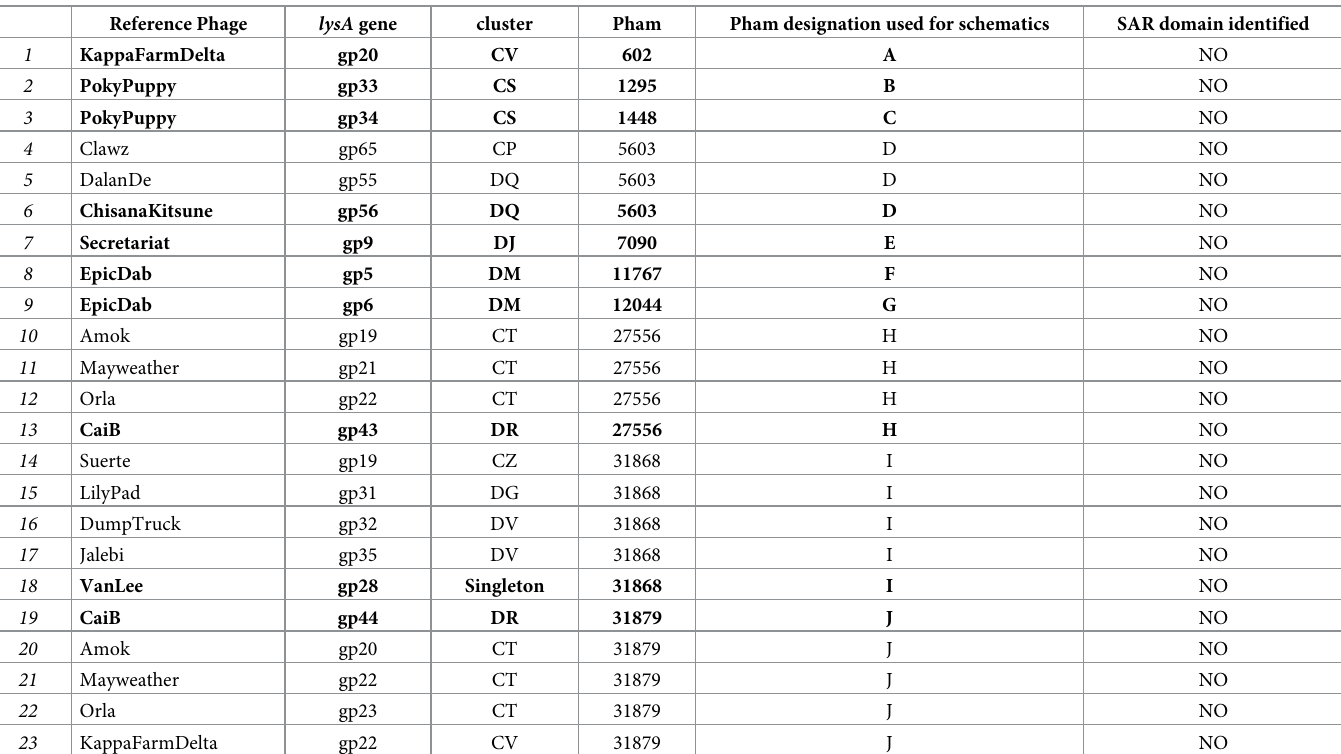
Table 2. Identification of lysA